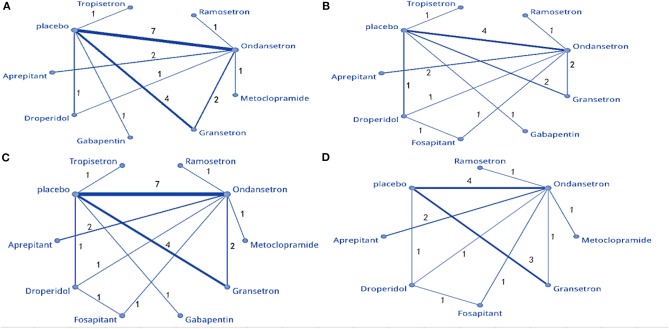
Network meta-analysis plot: (A) PON, (B) POV at 0–2 h, (C) POV at 0–24 h, and (D) POV at 0–48 h.